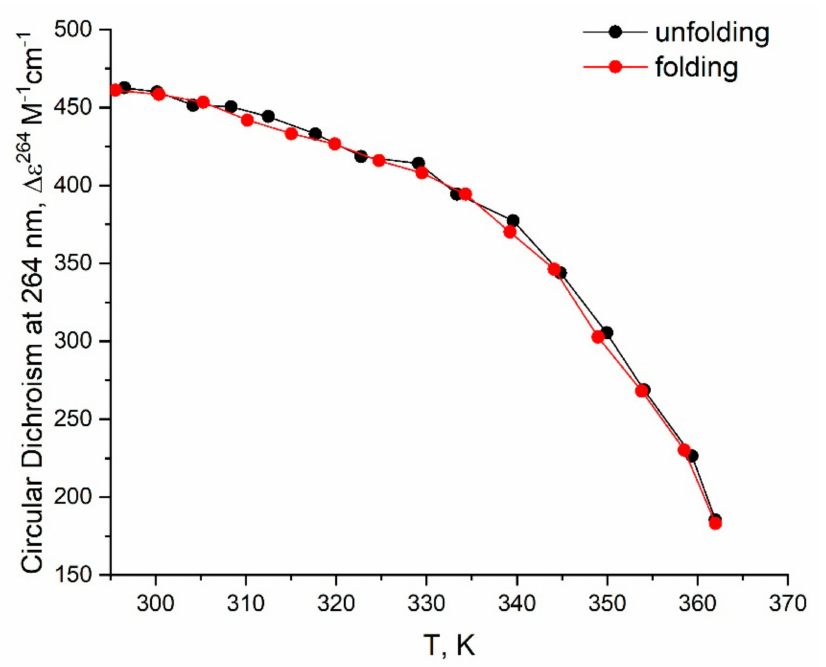
Figure A6. CD unfolding (black) and folding (red) profiles for bi-(AID-1-T) in buffer B (140 mM NaCl, 10 mM KCl; (Na + , K +